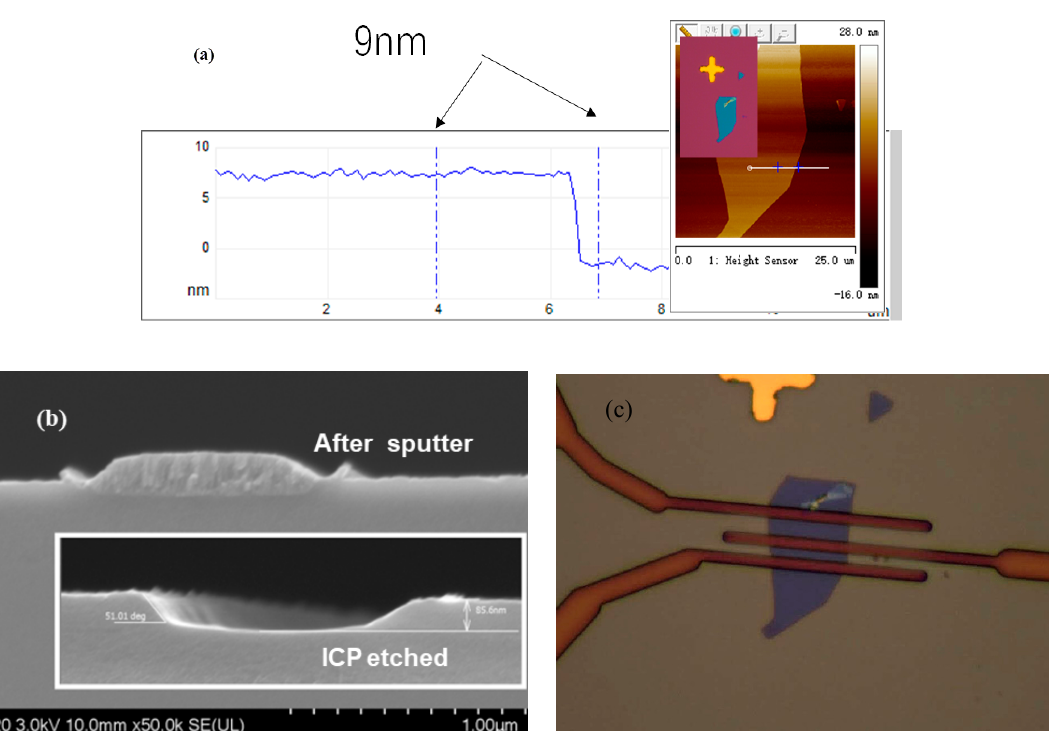
Figure 4. ( a ) AFM image of MoS 2 thickness; ( b ) SEM image of channel cross sectional surface after the Sputter; ( c )optical images of edge-contacted MoS 2 back-gate FET.